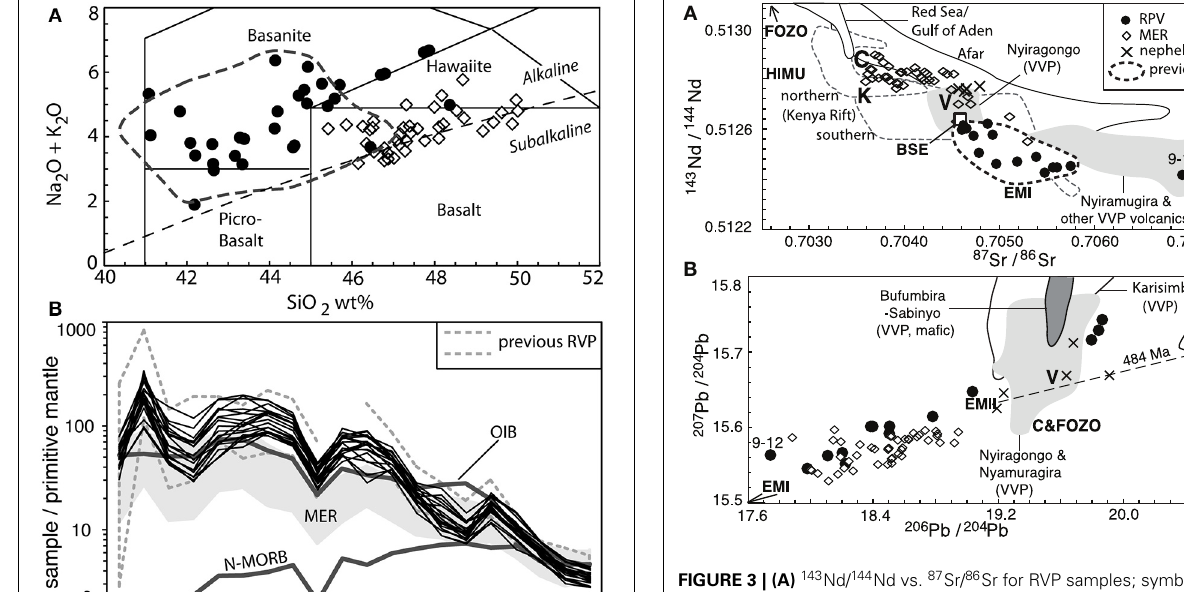
FIGURE 3 | (A) 143 Nd/ 144 Nd vs. 87 Sr/ 86 Sr for RVP samples; symbol used is 2X larger than analytical error. EMI, C, FOZO, EMII, BSE, and HIMU are proposed mantle endmembers (Hart et al., 1992; White, 2010). V, K, and C are the proposed Virunga (this study, modified from Chakrabarti et al., 2009), Kenyan (Rogers et al., 2000) and Afar (Rooney et al., 2012) mantle plumes, respectively. (B) 206 Pb/ 204 Pb vs. 208 Pb/ 204 Pb and 206 Pb/ 204 Pb vs. 207 Pb/ 204 Pb for RVP and MER samples; symbol used is 2X larger than analytical error ( Table 1 ). Nyiragongo and Nyiramugira lavas from the Virunga Volcanic Province (VVP) are shown as gray shaded field as is the range of “classic” HIMU islands (St. Helena and the Cook–Australs; data from the GEOROC database (http://georoc . mpch-mainz . gwdg . de/)). Fields for other EARS volcanic centers are shown for reference. In these diagrams, V and C have the ∼ same 206 Pb/ 204 Pb values. Dash line (labeled 484 Ma) is part of the Nyiragongo nephelinite isochron/mixing lines (Vollmer and Norry, 1983a,b).